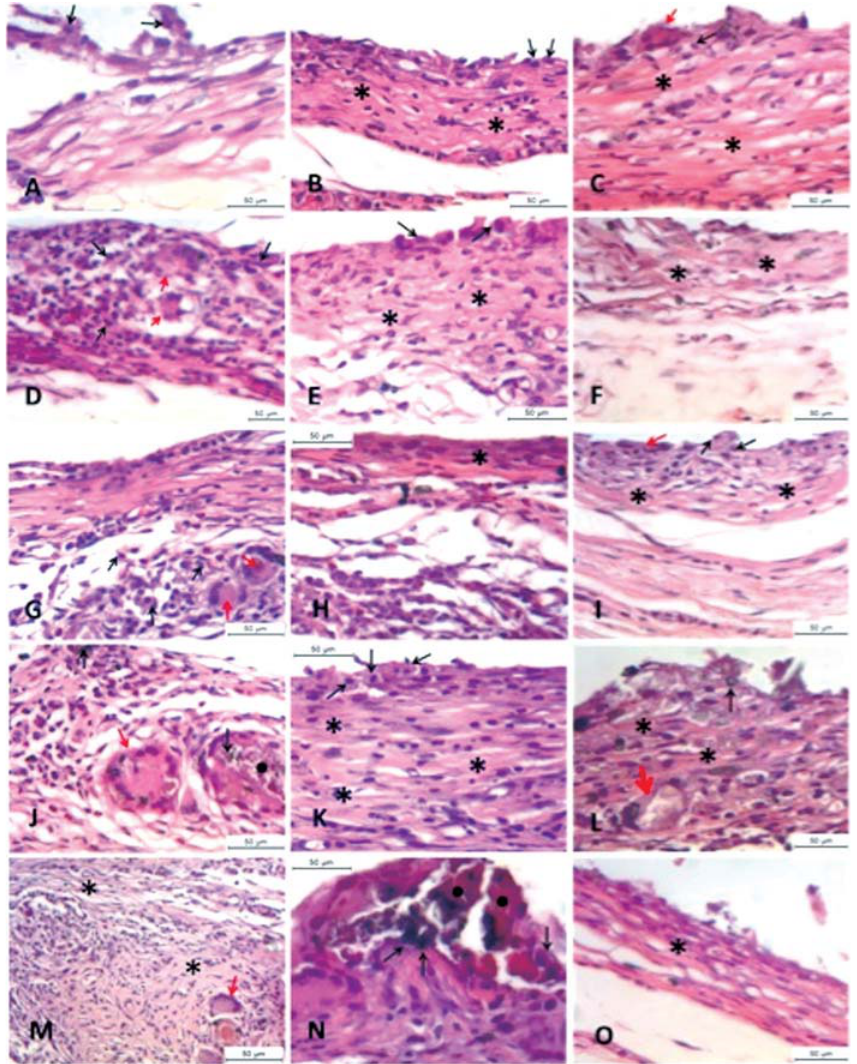
Figure 1- (A–C) Group 1 (0%WPC); (D–F) Group 2 (15%WPC); (G–I) Group 3 (20%WPC); (J–L) Group 4 (30%WPC); (cid:21)(cid:29)"#(cid:26)(cid:9)$(cid:16)(cid:18)(cid:28)(cid:20)(cid:9)(cid:25)(cid:9)(cid:21)(cid:25)(cid:23)&’*+(cid:26)(cid:24)(cid:9)/(cid:7)(cid:9)<(cid:25)(cid:9)(cid:4)(cid:6)(cid:12)(cid:10)>(cid:9)(cid:6)(cid:9)(cid:5)(cid:19)(cid:16)(cid:18)(cid:3)(cid:2)(cid:5)(cid:9)(cid:2)(cid:3)(cid:30)(cid:6)(cid:17)(cid:17)(cid:6)(cid:7)(cid:18)(cid:16)(cid:12)(cid:9)(cid:2)(cid:3)(cid:14)(cid:11)(cid:7)(cid:16)(cid:6)(cid:7)(cid:8)>(cid:9)(cid:17)(cid:18)(cid:4)(cid:8)(cid:16)(cid:6)(cid:7)(cid:8)(cid:9)!(cid:2)(cid:7)(cid:19)(cid:9)(cid:20)(cid:16)(cid:8)(cid:4)(cid:18)(cid:17)(cid:2)(cid:3)(cid:6)(cid:3)(cid:5)(cid:8)(cid:9)(cid:18)(cid:15)(cid:9)(cid:17)(cid:6)(cid:5)(cid:16)(cid:18)(cid:20)(cid:19)(cid:6)(cid:13)(cid:8)(cid:9) (black arrow) is observed, presence of giant multinuclear cells (red arrow), areas with Portland cement particles involved !(cid:2)(cid:7)(cid:19)(cid:9)(cid:13)(cid:2)(cid:6)(cid:3)(cid:7)(cid:9)(cid:5)(cid:8)(cid:11)(cid:11)(cid:10)(cid:9)(cid:21)?(cid:11)(cid:6)(cid:5)K(cid:9)(cid:5)(cid:2)(cid:16)(cid:5)(cid:11)(cid:8)(cid:26)(cid:9)(cid:6)(cid:3)(cid:4)(cid:9)(cid:6)(cid:9)(cid:17)(cid:2)(cid:11)(cid:4)(cid:9)(cid:20)(cid:16)(cid:8)(cid:10)(cid:8)(cid:3)(cid:5)(cid:8)(cid:9)(cid:18)(cid:15)(cid:9)(cid:14)?(cid:8)(cid:16)(cid:9)(cid:5)(cid:18)(cid:3)(cid:3)(cid:8)(cid:5)(cid:7)(cid:2)(cid:31)(cid:8)(cid:9)(cid:7)(cid:2)(cid:10)(cid:10)(cid:28)(cid:8)(cid:9)(cid:21)(cid:6)(cid:10)(cid:7)(cid:8)(cid:16)(cid:2)(cid:10)K(cid:26)(cid:9)(cid:2)(cid:3)(cid:9)(cid:6)(cid:11)(cid:11)(cid:9)(cid:13)(cid:16)(cid:18)(cid:28)(cid:20)(cid:10)(cid:24)(cid:9)/(cid:7)(cid:9)N(cid:23)(cid:9)(cid:4)(cid:6)(cid:12)(cid:10)>(cid:9)(cid:6)(cid:9)(cid:4)(cid:8)(cid:5)(cid:16)(cid:8)(cid:6)(cid:10)(cid:8)(cid:9) (cid:2)(cid:3)(cid:9)(cid:7)(cid:19)(cid:8)(cid:9)(cid:2)(cid:3)(cid:30)(cid:6)(cid:17)(cid:17)(cid:6)(cid:7)(cid:18)(cid:16)(cid:12)(cid:9)(cid:2)(cid:3)(cid:14)(cid:11)(cid:7)(cid:16)(cid:6)(cid:7)(cid:8)(cid:9)(cid:6)(cid:3)(cid:4)(cid:9)(cid:6)(cid:9)(cid:4)(cid:2)(cid:10)(cid:5)(cid:16)(cid:8)(cid:7)(cid:8)(cid:9)(cid:2)(cid:3)(cid:5)(cid:16)(cid:8)(cid:6)(cid:10)(cid:8)(cid:9)(cid:2)(cid:3)(cid:9)(cid:14)?(cid:8)(cid:16)(cid:9)(cid:5)(cid:18)(cid:3)(cid:3)(cid:8)(cid:5)(cid:7)(cid:2)(cid:31)(cid:8)(cid:9)(cid:7)(cid:2)(cid:10)(cid:10)(cid:28)(cid:8)(cid:9)(cid:21)(cid:6)(cid:10)(cid:7)(cid:8)(cid:16)(cid:2)(cid:10)K(cid:26)(cid:9)(cid:2)(cid:3)(cid:9)(cid:5)(cid:18)(cid:17)(cid:20)(cid:6)(cid:16)(cid:2)(cid:10)(cid:18)(cid:3)(cid:9)!(cid:2)(cid:7)(cid:19)(cid:9)(cid:7)(cid:19)(cid:8)(cid:9)<(cid:25)(cid:9)(cid:4)(cid:6)(cid:12)(cid:10)(cid:9) period were observed. Furthermore, at 30 days the presence of macrophage cells (black arrow) is predominant. Areas with Portland cement particles involved with giant cells are still present in this period (black circle). At 60 days, the chronic (cid:2)(cid:3)(cid:30)(cid:6)(cid:17)(cid:17)(cid:6)(cid:7)(cid:18)(cid:16)(cid:12)(cid:9)(cid:16)(cid:8)(cid:10)(cid:20)(cid:18)(cid:3)(cid:10)(cid:8)(cid:9)(cid:2)(cid:10)(cid:9)(cid:17)(cid:2)(cid:11)(cid:4)(cid:9)!(cid:2)(cid:7)(cid:19)(cid:9)(cid:2)(cid:10)(cid:18)(cid:11)(cid:6)(cid:7)(cid:8)(cid:4)(cid:9)(cid:17)(cid:6)(cid:5)(cid:16)(cid:18)(cid:20)(cid:19)(cid:6)(cid:13)(cid:8)Q(cid:11)(cid:2)K(cid:8)(cid:9)(cid:5)(cid:8)(cid:11)(cid:11)(cid:9)(cid:21)?(cid:11)(cid:6)(cid:5)K(cid:9)(cid:6)(cid:16)(cid:16)(cid:18)!(cid:26)(cid:9)(cid:6)(cid:3)(cid:4)(cid:9)(cid:13)(cid:2)(cid:6)(cid:3)(cid:7)(cid:9)(cid:5)(cid:8)(cid:11)(cid:11)(cid:10)(cid:9)(cid:21)(cid:16)(cid:8)(cid:4)(cid:9)(cid:6)(cid:16)(cid:16)(cid:18)!(cid:26)(cid:24)(cid:9)R(cid:19)(cid:8)(cid:9)(cid:20)(cid:16)(cid:8)(cid:10)(cid:8)(cid:3)(cid:5)(cid:8)(cid:9)